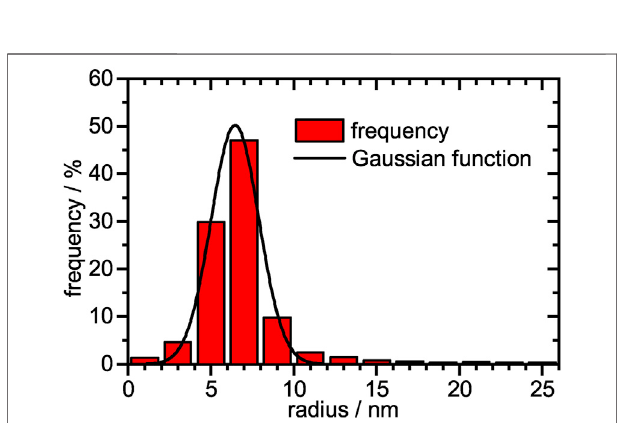
FIGURE 2 | TEM micrographs of the core-shell microgels containing Pd nanoparticles. Two different magni fi cations with the respective scale bars are shown.